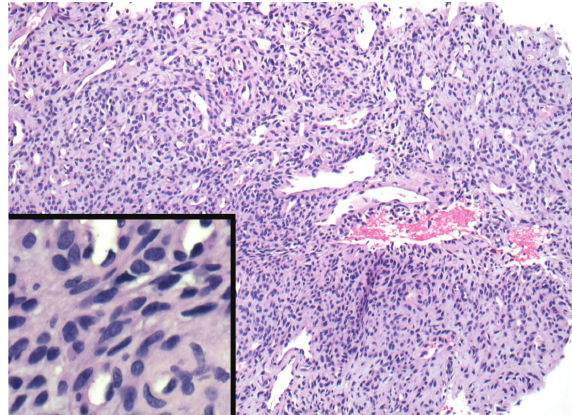
Figure 3: Photomicrograph (H&E stain, 10x; inset lower left, 60x) showing uniform bland appearing spindle cells with hemangio- pericytoma-like vasculature. Rare multinucleate giant cells (not pictured) were also